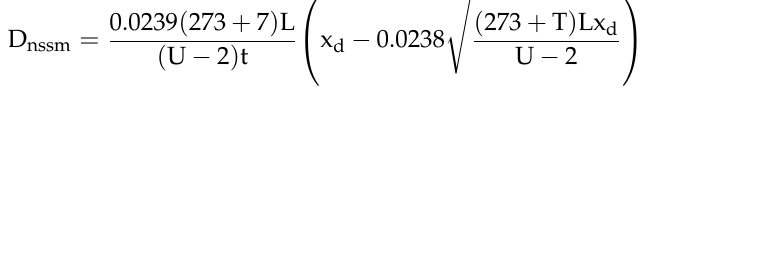
Figure 7. Chloride penetration measurement.